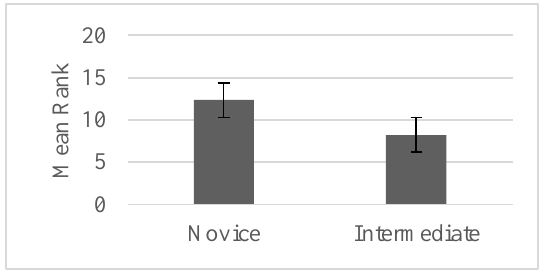
Figure 10. Right-Eye Pupil Size Differences between Nov- ice and Intermediates under Right-Hand Condition in Catch